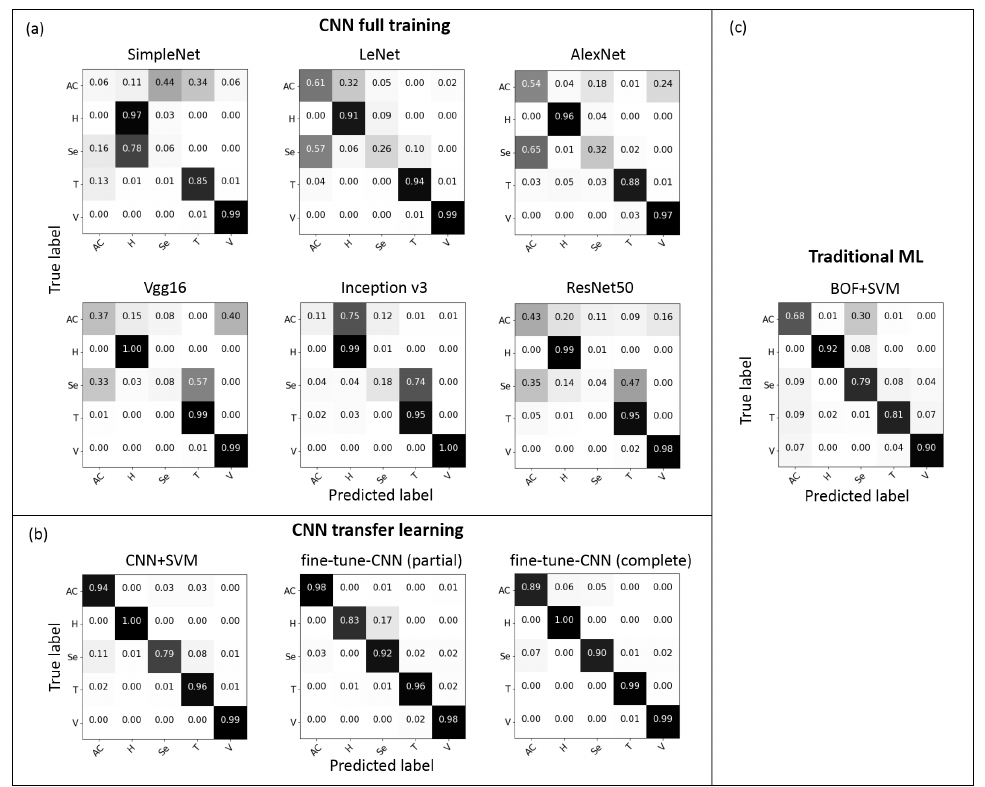
Figure 9. Patch-wise confusion matrices (%) of all the classification frameworks. ( a ) CNNs fully trained on histopathological images. ( b ) Transfer learning methodologies. ( c ) Classification framework based on bag of features and support vector